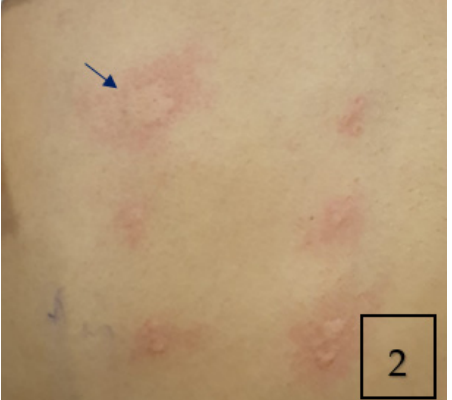
Figure 2. Skin prick allergy test showing positive wheal and flare of 4 × 9 mm in response to aspergillus fumigatus antigen (Arrow).